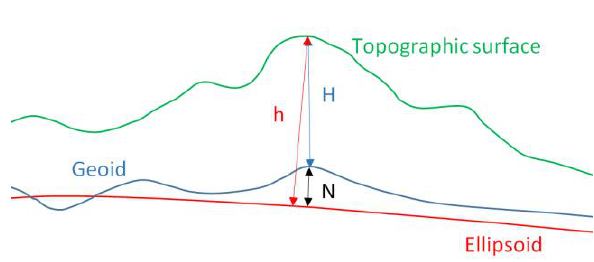
Figure 4. Comparison of the Earth surface in local area (topographic surface) and its models (ellipsoid and geoid): you can see the relationships between ellipsoidal height (h), orthometric height (H), and geoid undulation (N). For each GCP, two values of geoid undulation are obtained, the one derived from the EGM2008 model and the other derived from the monograph of the point. The values of the deviation Δ between the two undulations are thus obtained, to be used subsequently for the